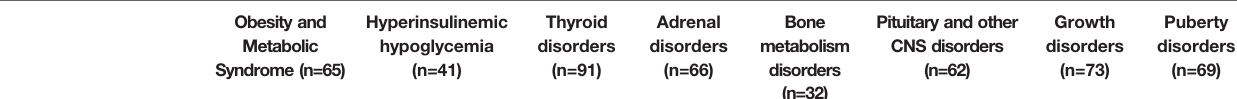
TABLE 5 | Symptoms, complications, and outcomes of pediatric endocrine cases other than diabetes during the COVID-19 pandemic by clinical